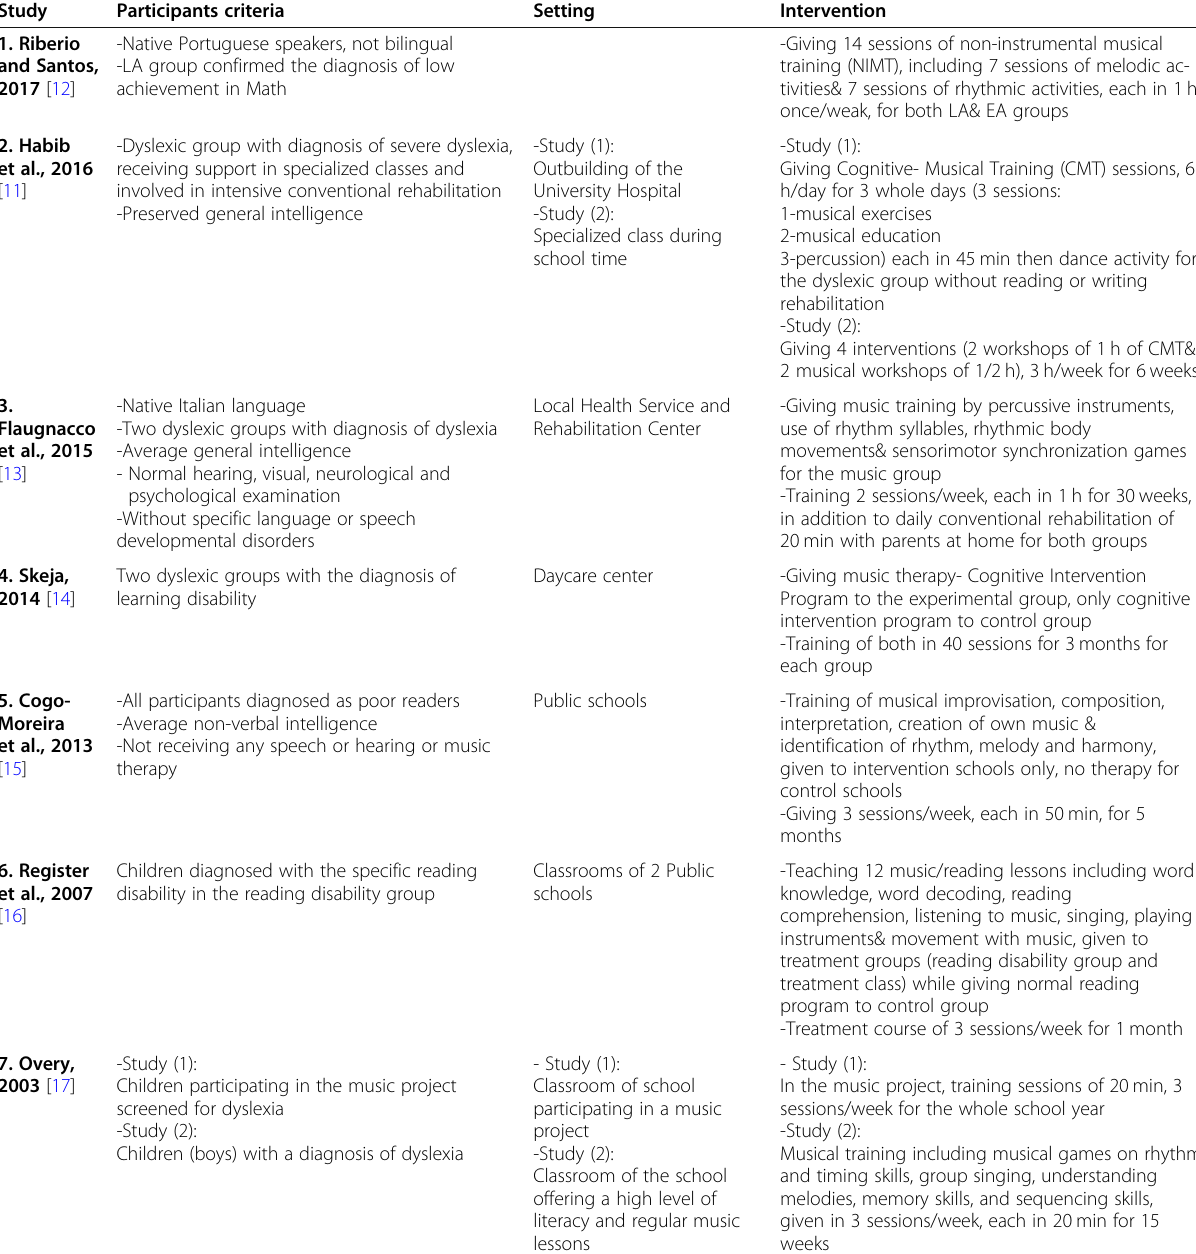
Table 2 Summary of criteria of participants, settings, and interventional methods of included